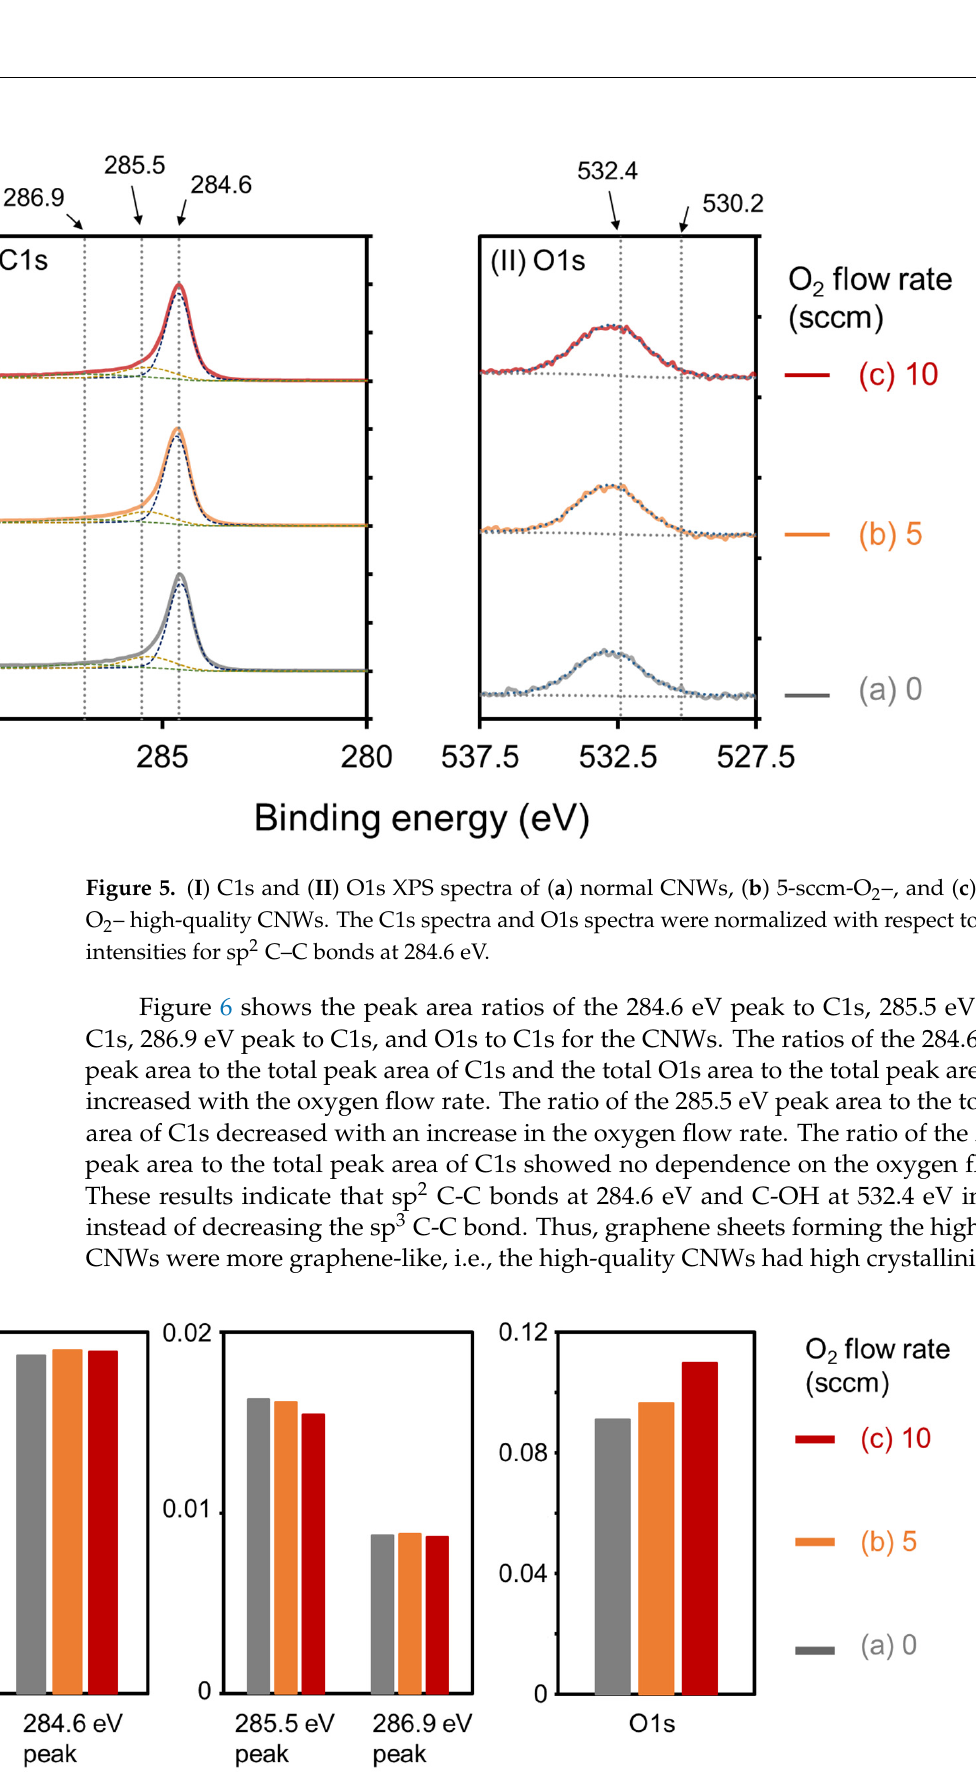
Figure 6. Ratios of each peak area to the total area of C1s for the ( a ) normal CNWs, and the high- quality CNWs with oxygen flow rates of ( b ) 5 sccm and ( c ) 10 sccm.